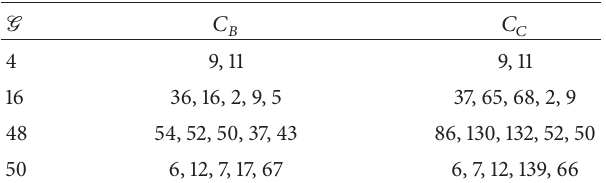
Table 3: Nodes with higher centrality in each test power